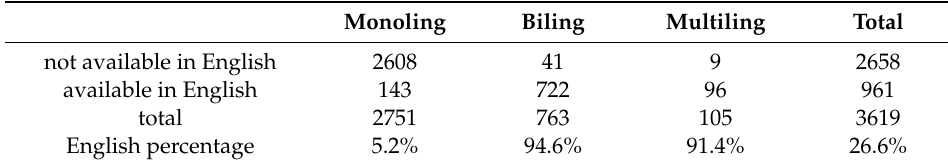
Table A50. English language availability (si).